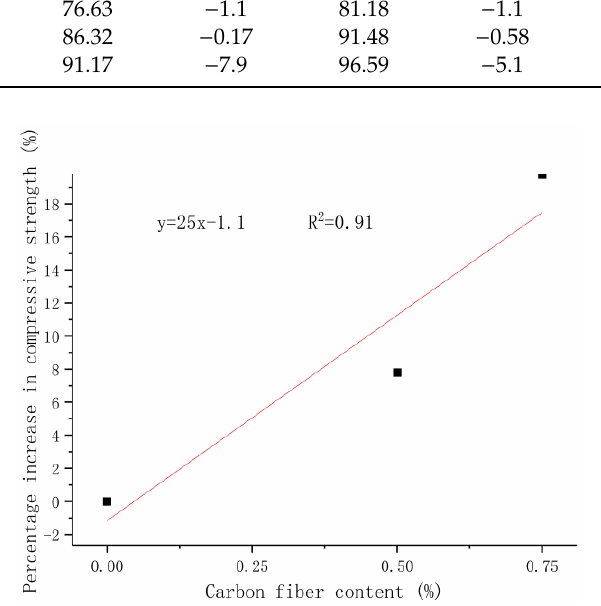
Figure 12. Relationship between compressive strength and fiber content. Table 9. Calculation of compressive strength of carbon-fiber RPC at 28 days.